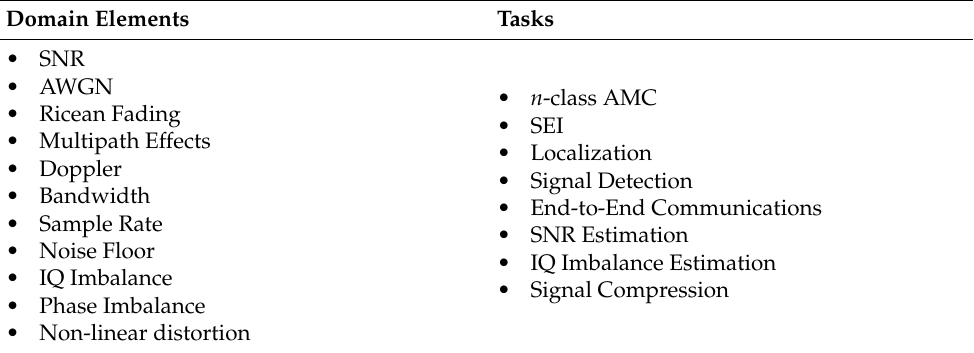
Table 1. Example RFML domain elements and